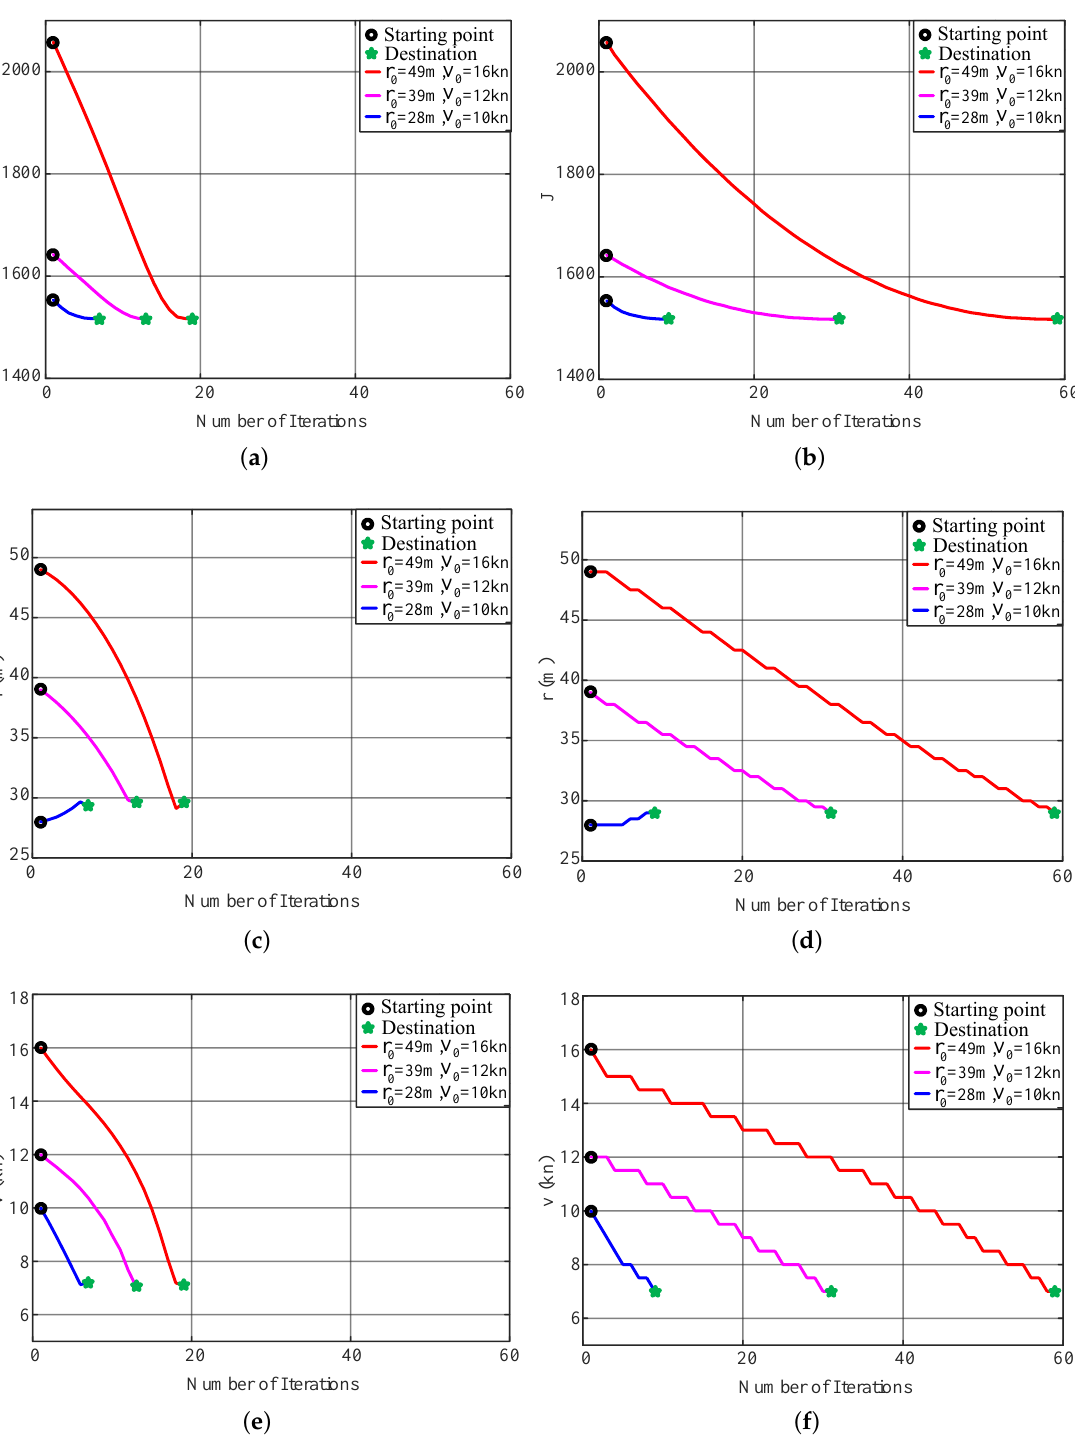
Figure 9. Optimization result graphs: ( a , c , e ) are the convergence curves of the cost function value and the two path parameters for each initial value set using TPA-IPT; ( b , d , f ) are their counterparts for the fixed step